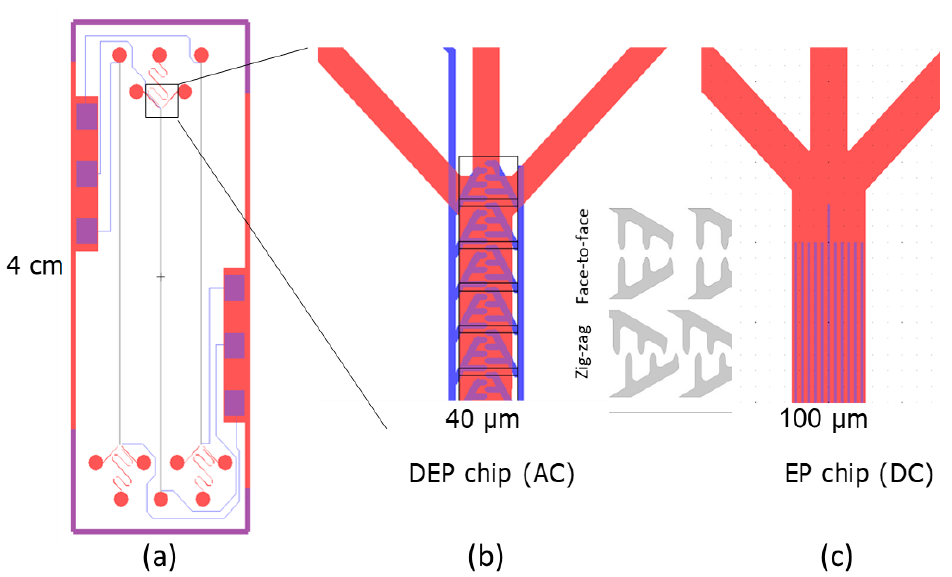
Figure 1. ( a ) The general chip design. ( b ) The channel contains a single channel with electrodes at the bottom. In the case of the AC chip, the electrodes are either in a zig-zag or face-to-face configuration (inset). ( c ) In the case of the DC chip, the electrodes are simple lines running parallel to the channel length.